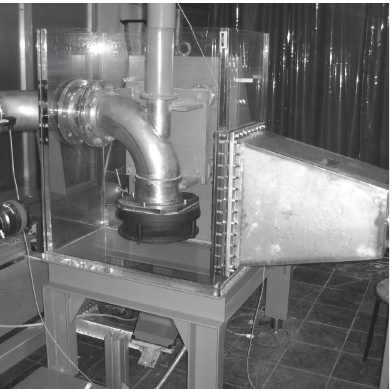
Figure 4: Intake chamber and pump with double inlet nozzle.